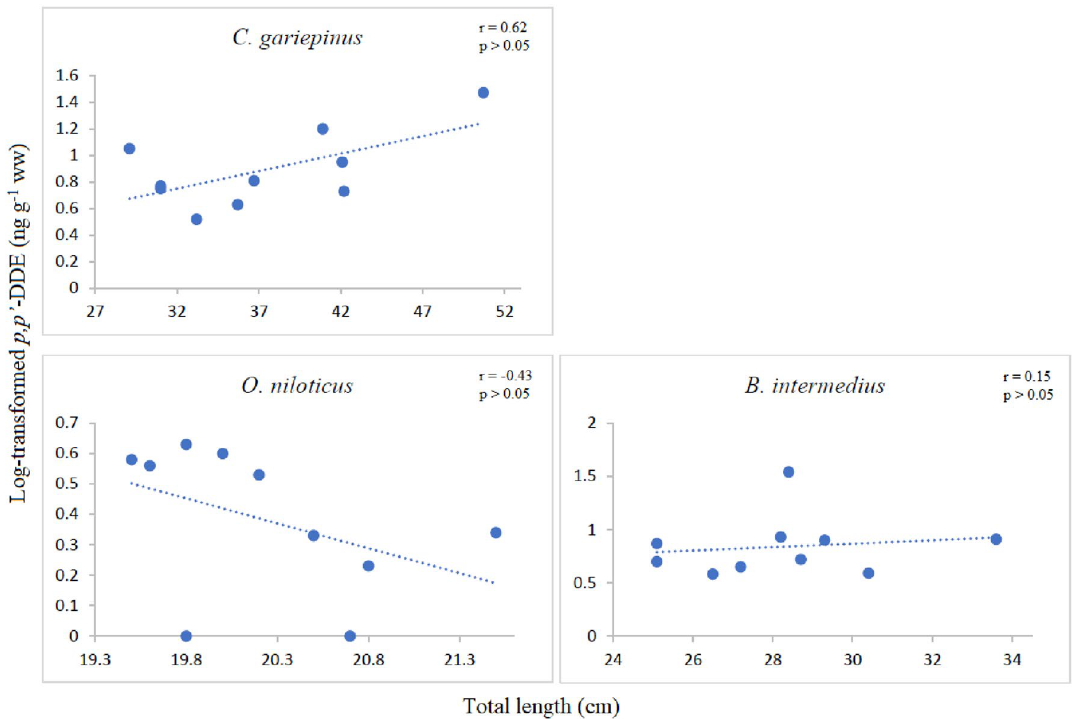
Fig. 3 Correlation between log-transformed p,p’ -DDE (ng g −1 ww), and total length